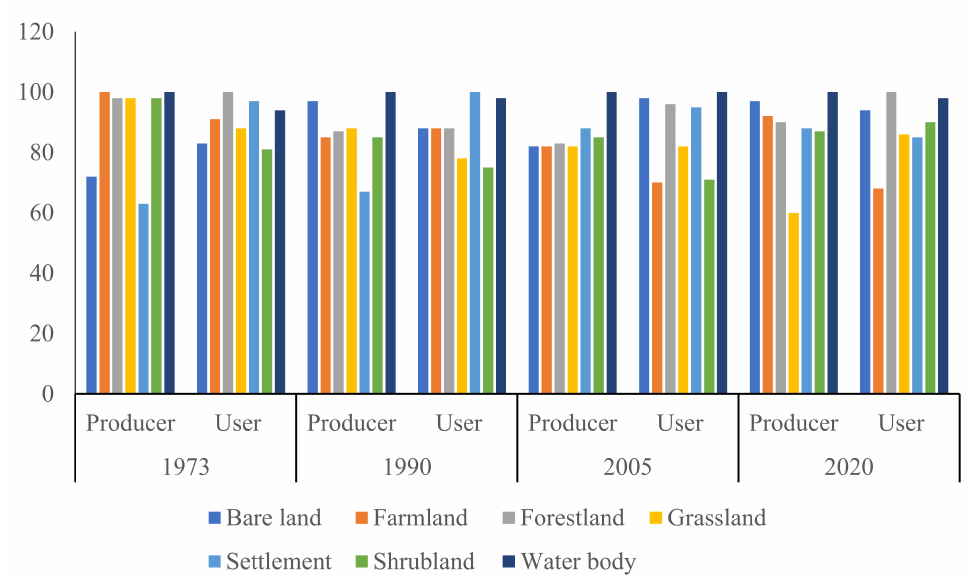
Figure 2. Error matrix showing the accuracy of the land use and land cover (LULC) type